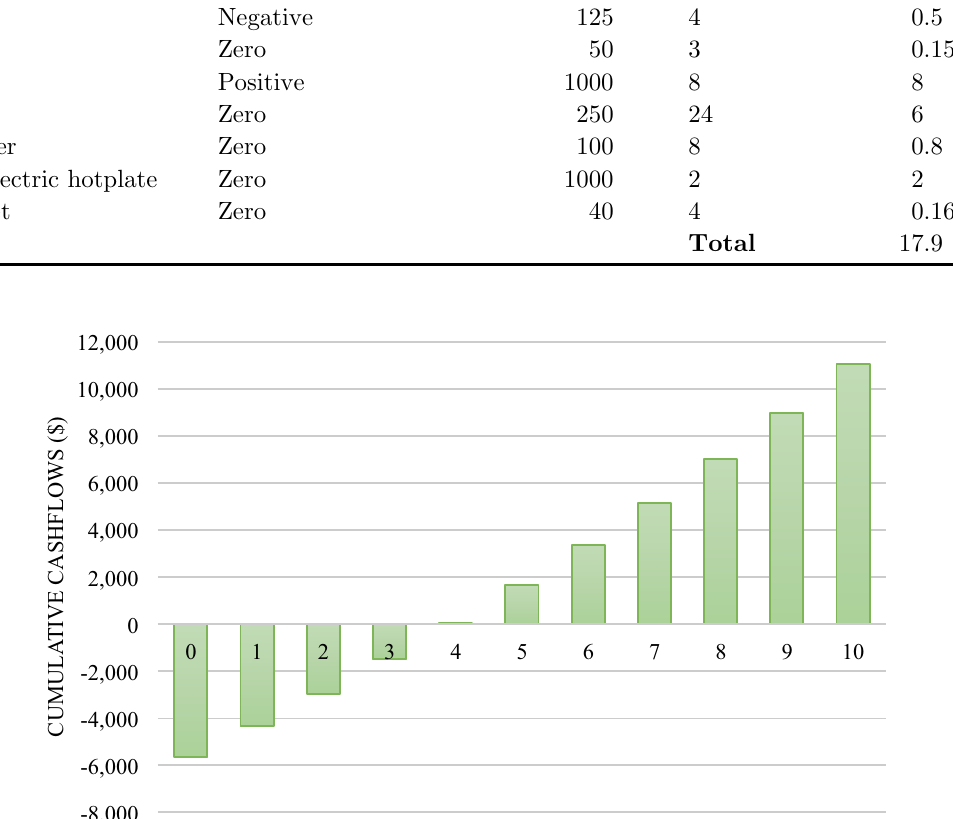
Fig. 3. Cumulative cash fl ow for the electricity part of the project (PV